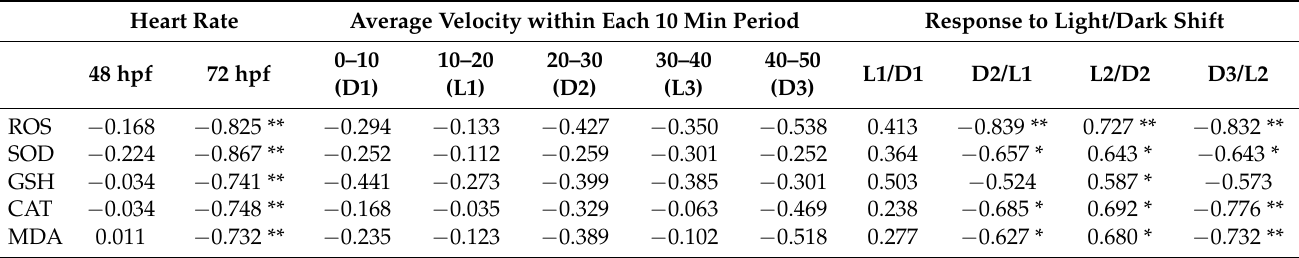
Table 3. Spearman’s correlation between the level of biomarkers for oxidative stress and the biological and behavioral parameters of zebrafish ( Danio rerio ) 1